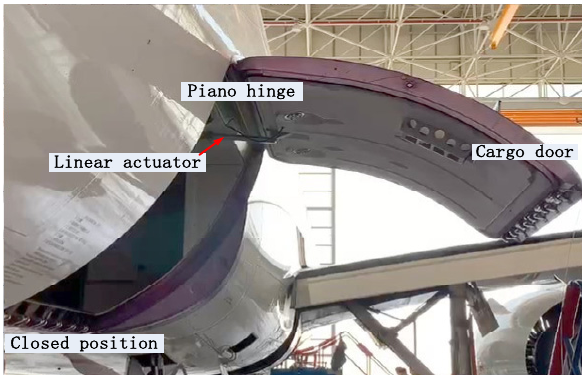
Figure 1. Installation of the cargo door actuation system.